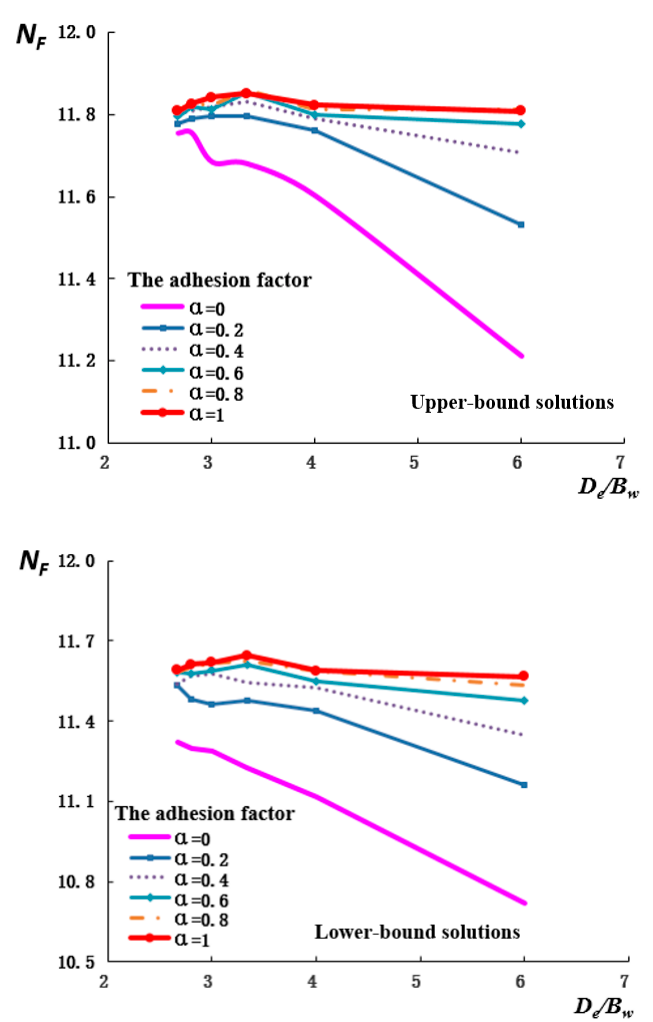
Figure 11. Relationship between the normalized ultimate lateral capacity ( N F ) of the four-wing pile and the wing–diameter ratio ( D e /B w ) when lateral-load angle β = 0. ( Top ) Upper-bound and ( Bottom ) lower-bound solutions from limit analysis with different pile–soil interaction coefficients (adhesion factors).